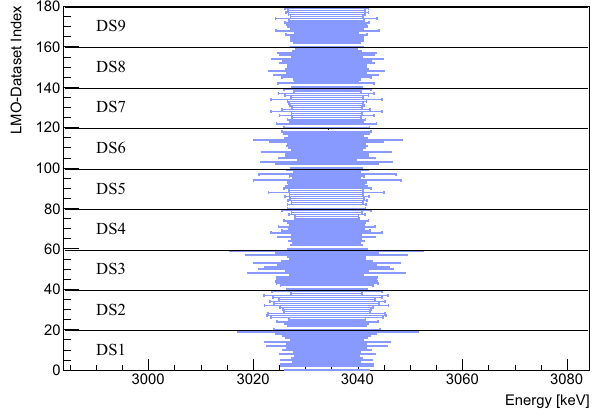
n counts based on the expected background rate. The chosen channel-dataset based ROIs are shown in Fig. 13, with an exposure weighted effective ROI width of ( 17 . 1 ± 4 . 5 )